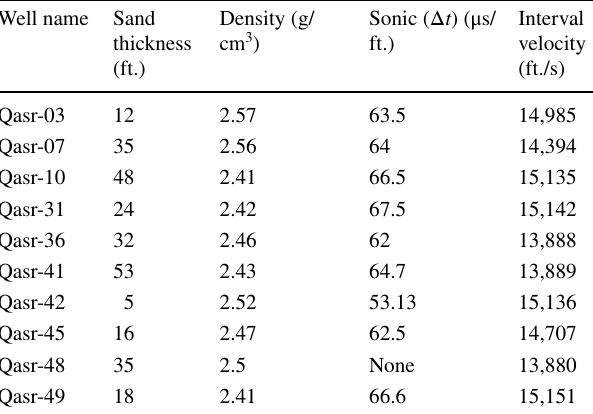
Table 1 Thickness, density, sonic and interval velocity of the Alam El Bueib-3D (D2) sandstone unit